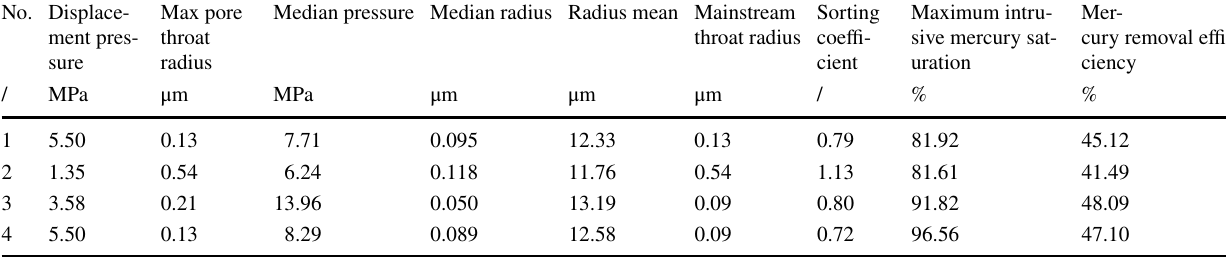
Table 3 Experimental data of high-pressure mercury intrusion in cores No. Displace- ment pres-